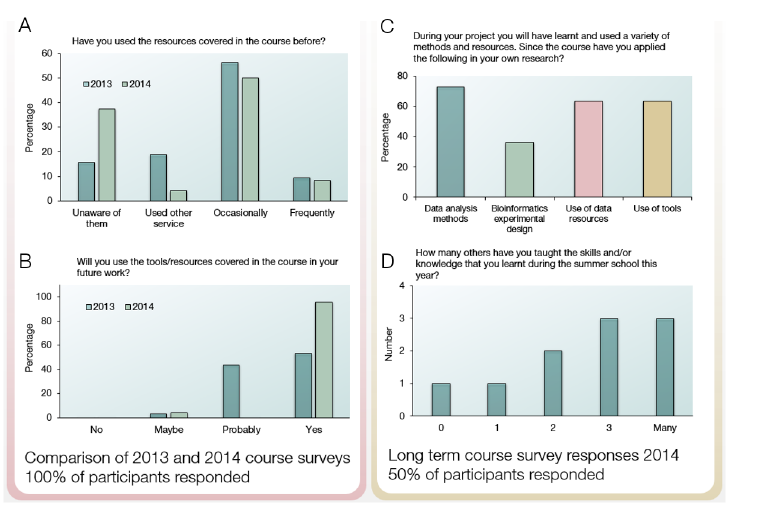
Fig 1. Summary of short- and long-term course